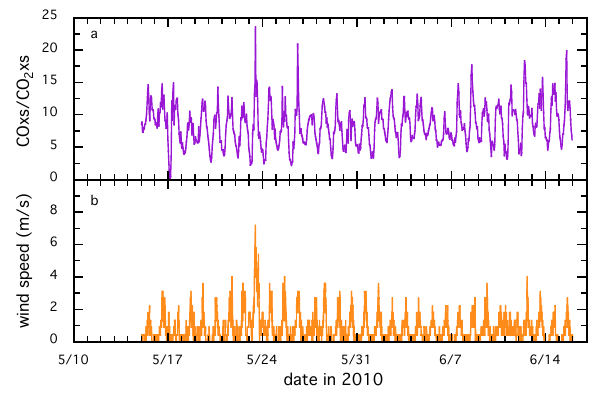
Fig. A3. Time series for (a) COxs/CO 2 xs and (b) wind speed in Pasadena during the CalNex-LA